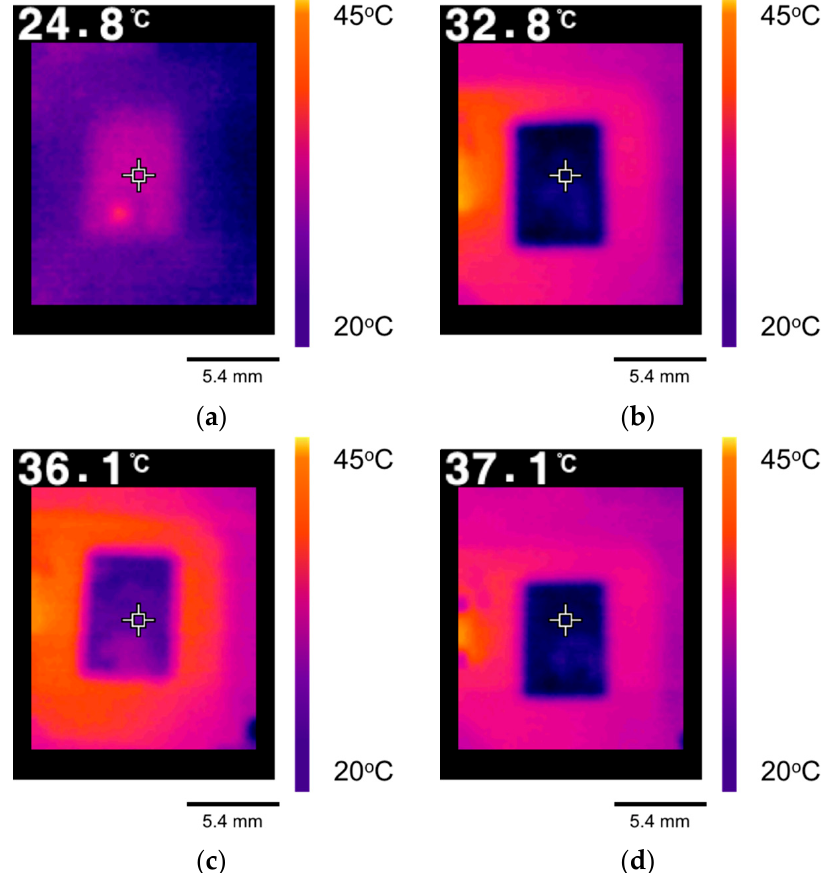
Figure 15. IR image of thermal pad ( a ) before operation, ( b ) after 30 min operation, ( c ) after 3 h operation and ( d ) after 5 h operation.